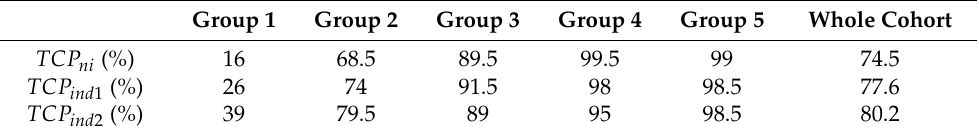
Table 2. Overall and group-specific tumor control probability when the injected activity is not adapted to each group ( TCP ni ), and when it is adapted according to Strategy 1 with ∆ A = 0.1 ∗ A 0 dose in the tumor (see Figure 2), and activities administered to each group are A 0 + ∆ A (Group